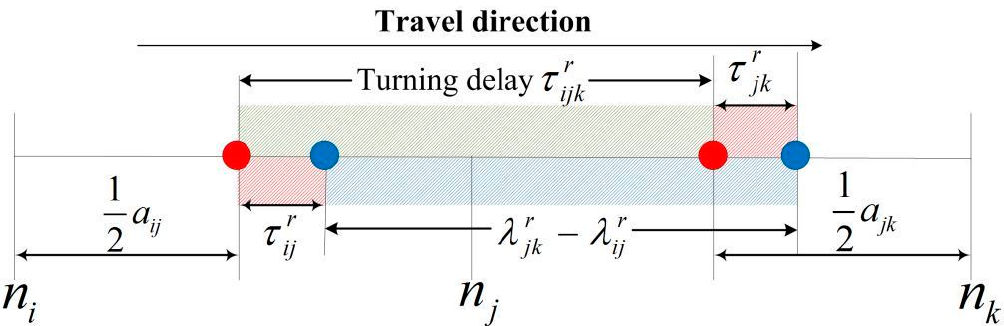
Figure 4. An illustration of sparsely sampling global positioning system (GPS) data on the links for Type I.